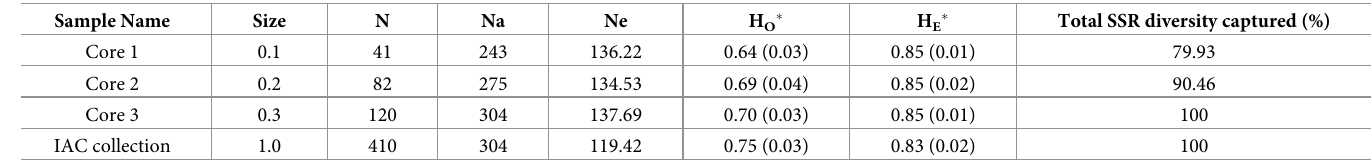
Table 2. SSR diversity within each core collection compared with that of the entire dataset (IAC collection).